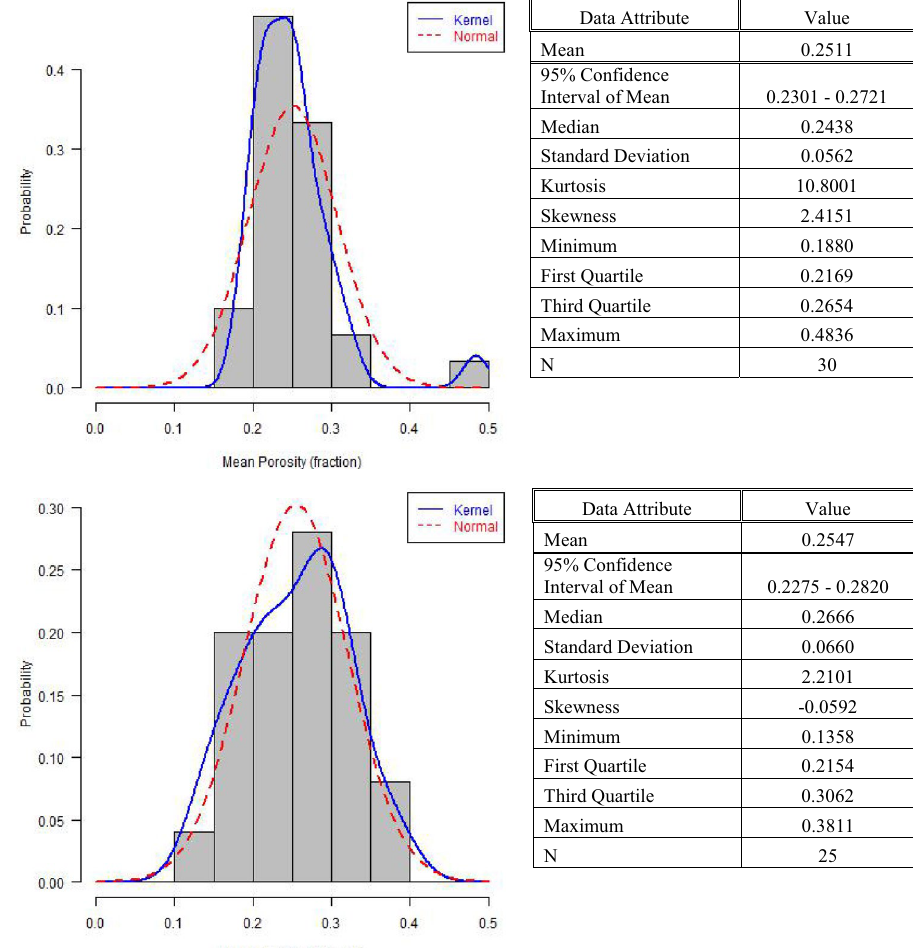
Fig. 15 Descriptive statistics and distributions of well-mean porosity values—Horizon X